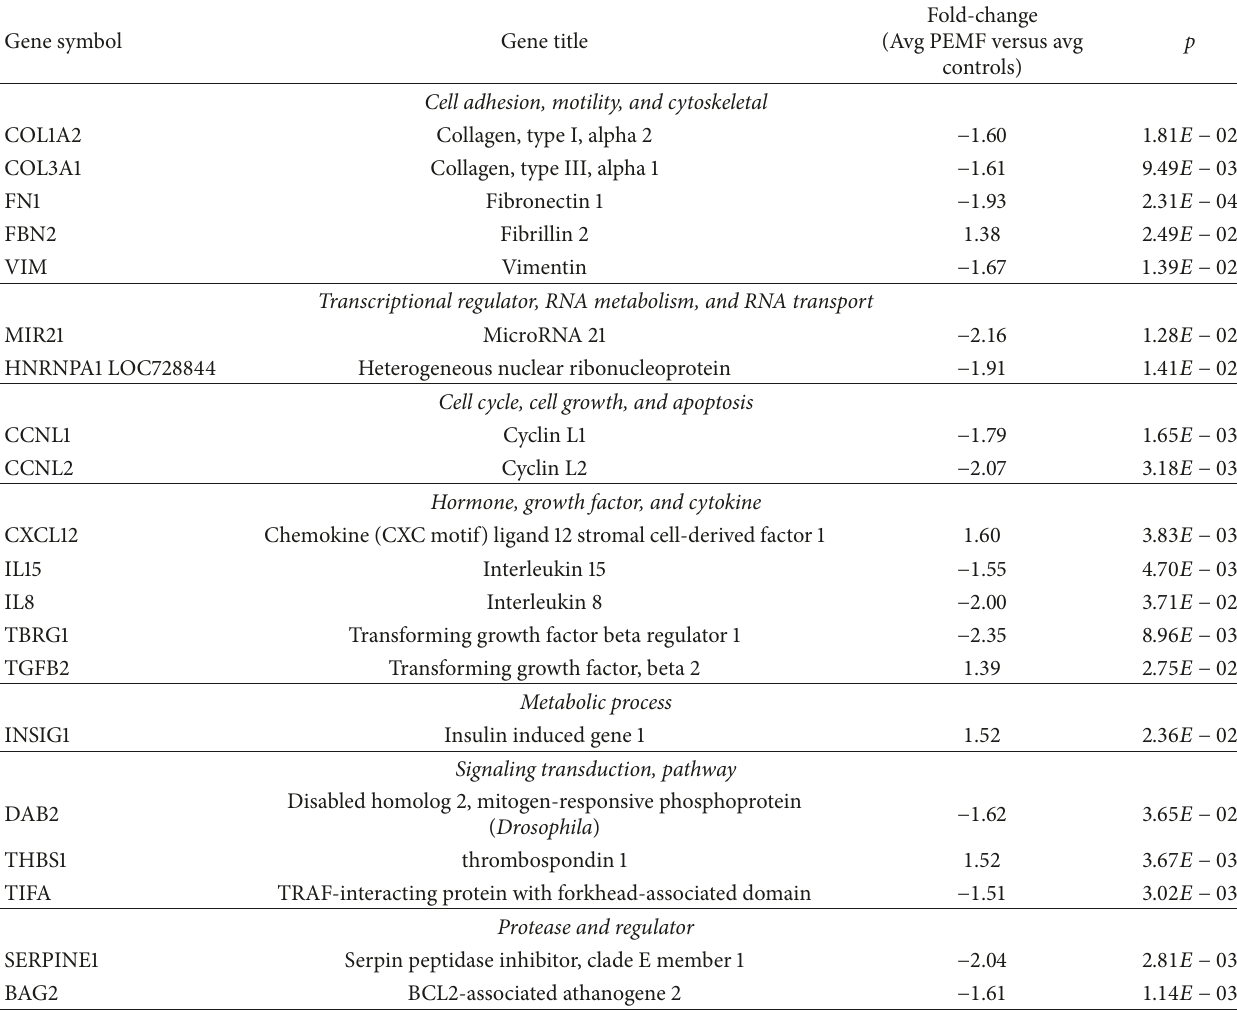
Table 4: Genes regulated by PEMF in mineralizing hBMSCs. Cells were from a normal 27-year-old female. Total RNA was isolated at day 33 of PEMF treatment. Analysis by Student’s t- test.